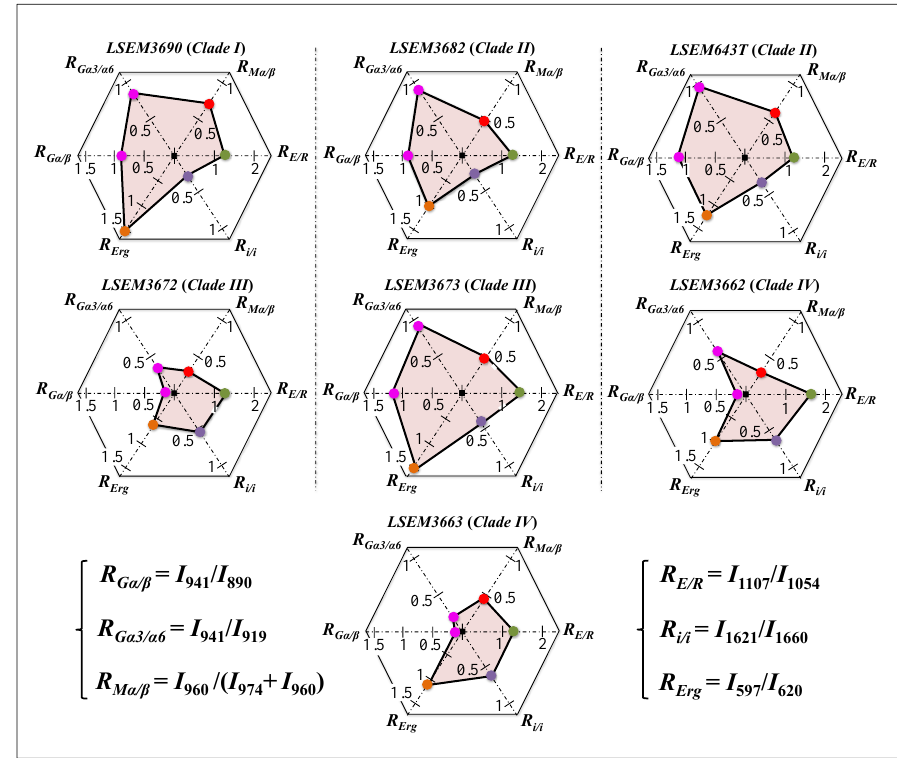
Figure 4. Summary of the computed Raman biochemical parameters R Gα/β = I 932 / I 890 , R G α3 / α6 = I 941 / I 919 , R Mα/β = I 960 / I 974 + I 960 , R E/R = I 1107 / I 1054 , R i/i = I 1644 / I 1660 , and R Erg = I 597 / I 620 , which are shown in a polar plot for each C. auris sample investigated (cf. labels in inset).